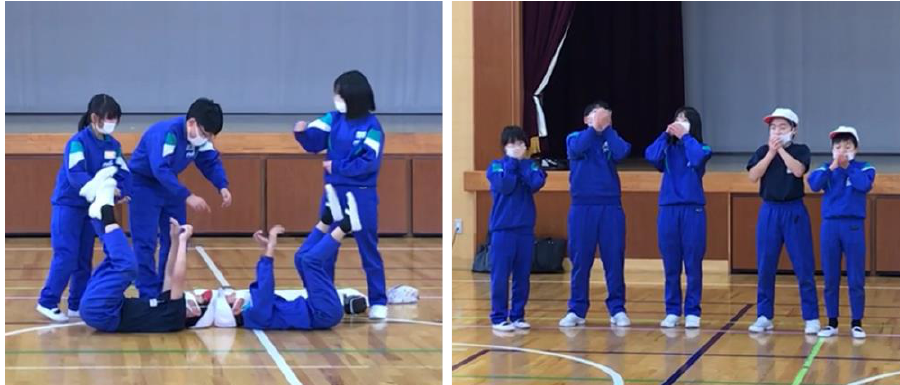
Figure 2. Students’ performance in the ACT workshop. Students’ performance “green tea” in the ACT workshop. They performed how tea leaves were picked ( left ), processed, served, and appreciated ( right ).